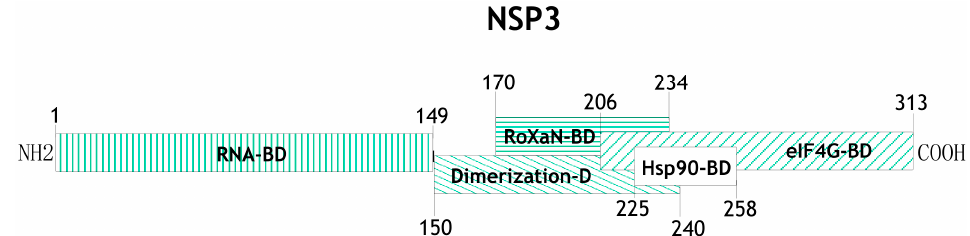
Figure 2. Schematic representation of the different functional domains that have been mapped on NSP3. Numbers indicate the amino acid positions at which each domain starts and ends (BD = binding domain). See text for details and references.